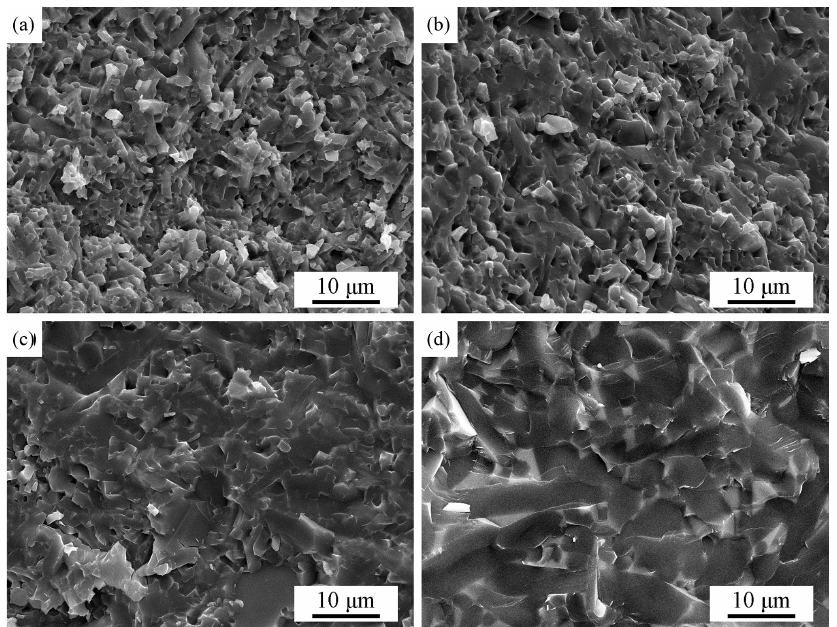
Figure 4: SEM micrographs of PSRB- β -SiAlON, (a) Z = 0.5, (b) Z = 1, (c) Z = 2, (d) Z =